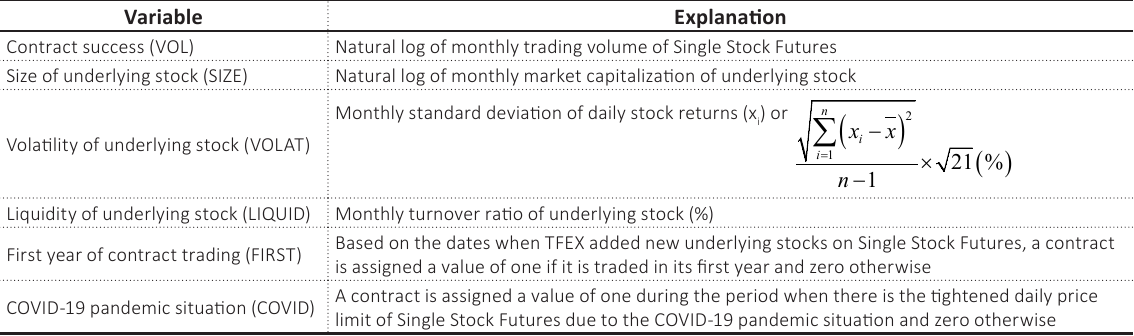
Table 2. List and measurement of variables Variable Explanation Contract success (VOL) Natural log of monthly trading volume of Single Stock Futures Size of underlying stock (SIZE) Natural log of monthly market capitalization of underlying stock Volatility of underlying stock (VOLAT)